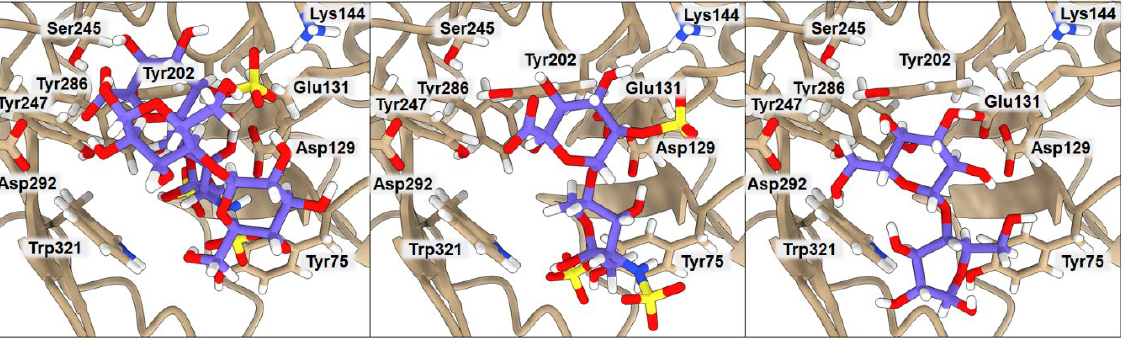
Figure 4. Ribbon representation of the hHyal-1 with docked HA-CB, HA, and CB saccharides, respectively. Key amino acids that create interactions with ligands are marked in black.